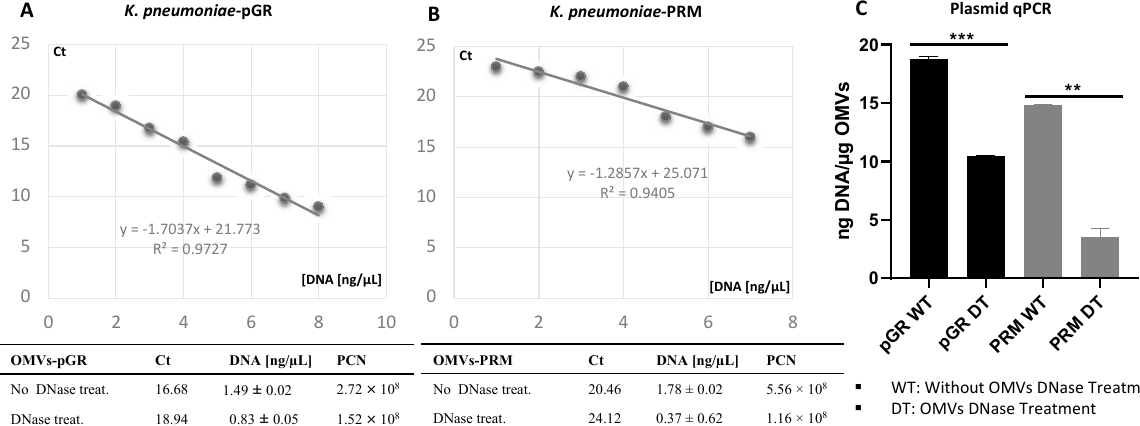
Figure 3. Determination of PCN in OMVs, using quantitative PCR standard curves. The standard curves were generated by DNasetreat. qPCR of the purified pGR ( A ) and PRM ( B ) plasmids. Histogram Graph of PGR and PRM cargo efficiency, before and after DNase treatment ( C ) ** p value < 0.005, *** p value <